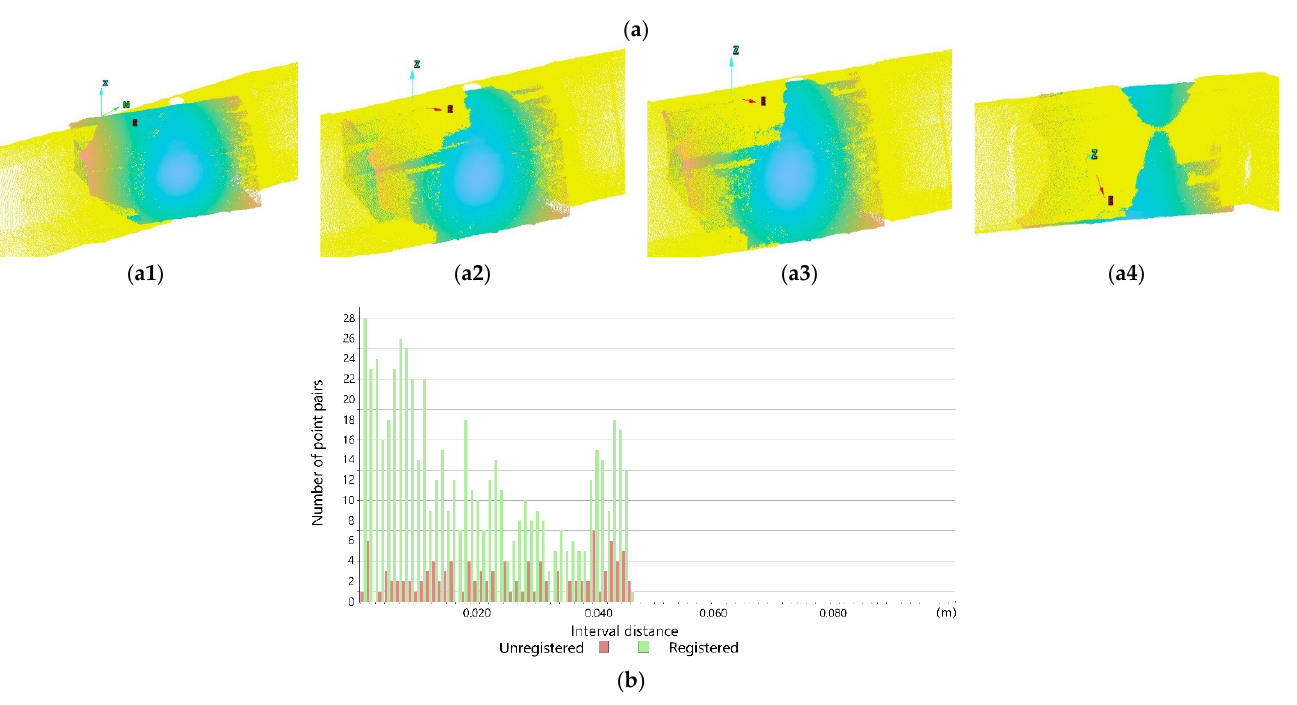
Figure 16. ( a ) Point cloud patching diagram of SVD + ICP algorithm. ( a1 ) Initial pose; ( a2 ) Coarse registration; ( a3 ) Fine registration side view; ( a4 ) Fine registration top view. ( b ) Fine registration verification diagram.